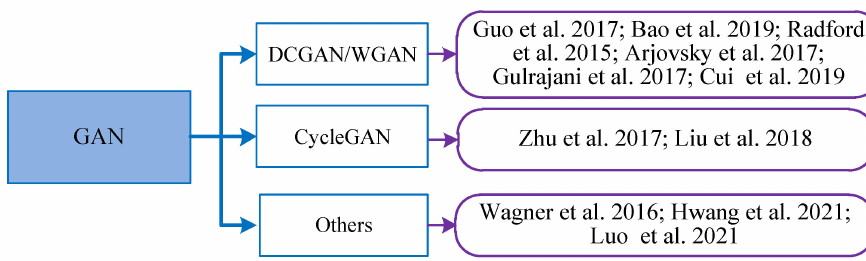
Figure 13. GAN for generating new samples in SAR ATR